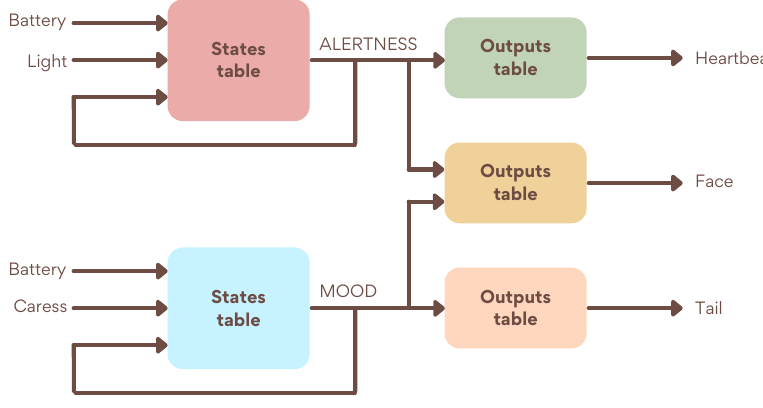
Figure 7. Model of the emotional state of the robot.